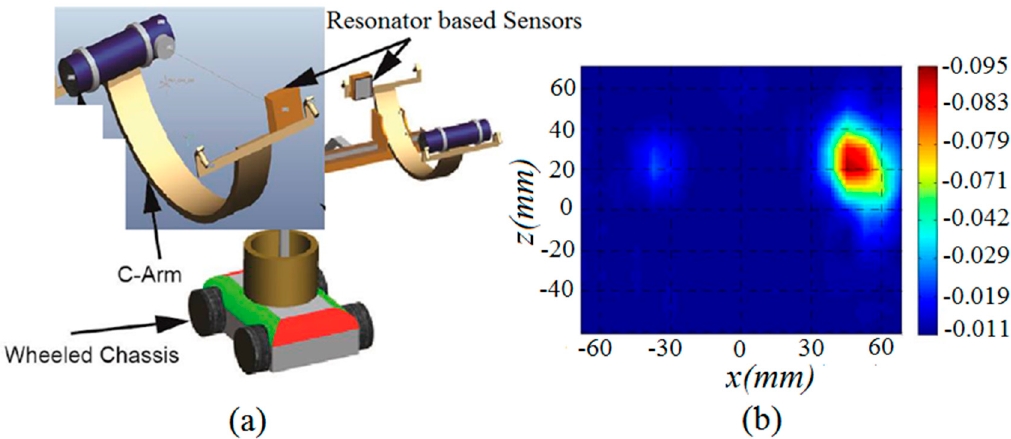
Figure 13. ( a ) Deployment of the proposed UWB antenna resonator based sensor in Pipeline Integrity Monitoring system; ( b ) calibrated S21 (magnitude) image from 2D scanning at 10 GHz for the industrial steel pipeline with two breaches on both sides (simulation).